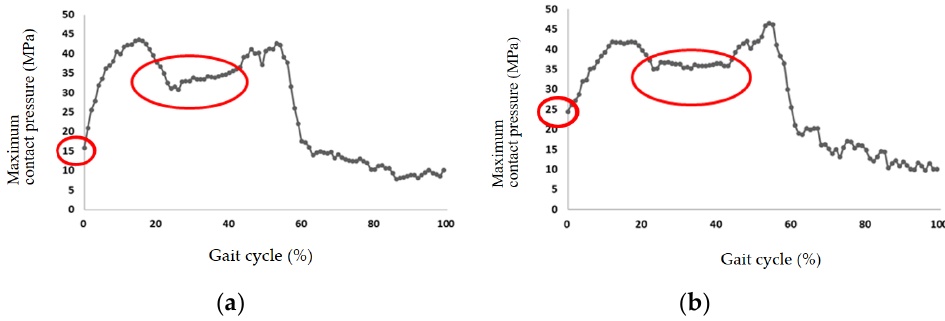
Figure 11. Comparison of maximum contact pressure in two gait mechanisms: ( a ) Normal gait mechanism; ( b ) Flatback gait mechanism. mechanism; ( b ) Flatback gait